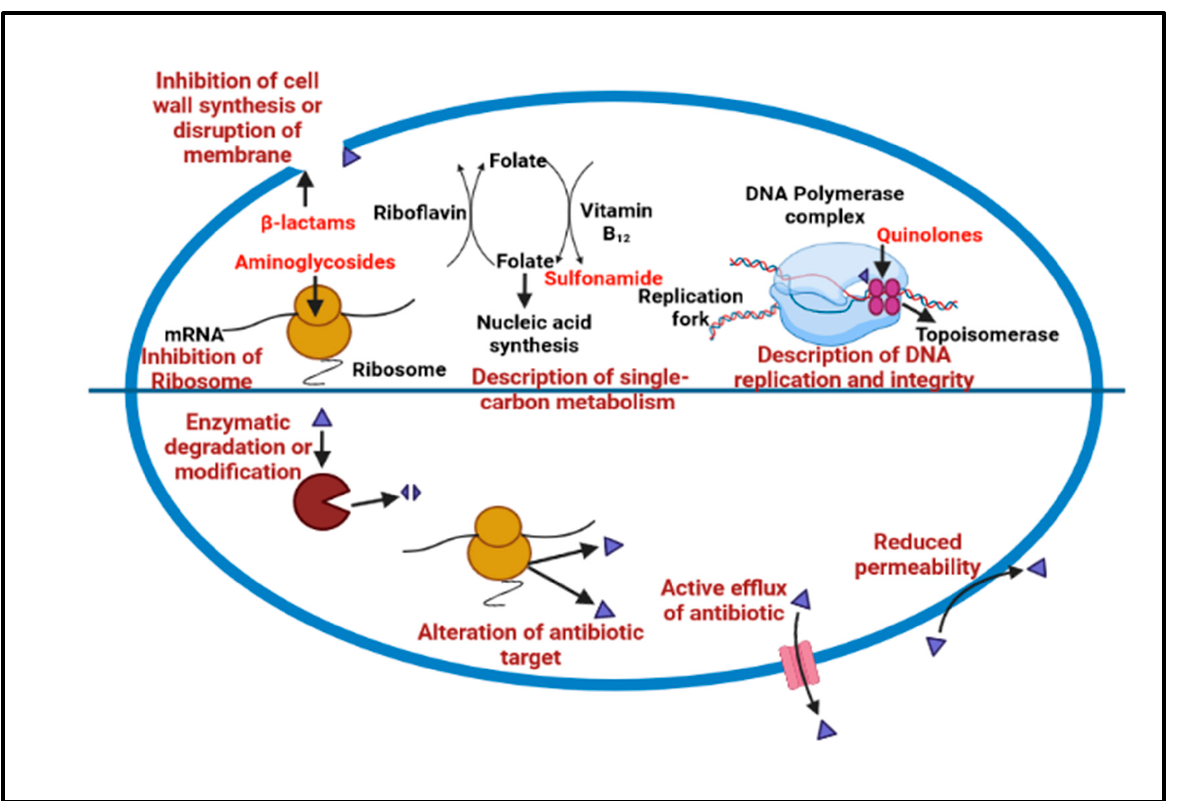
Figure 2. Show the common antibiotic resistance mechanism that leads to biofilm